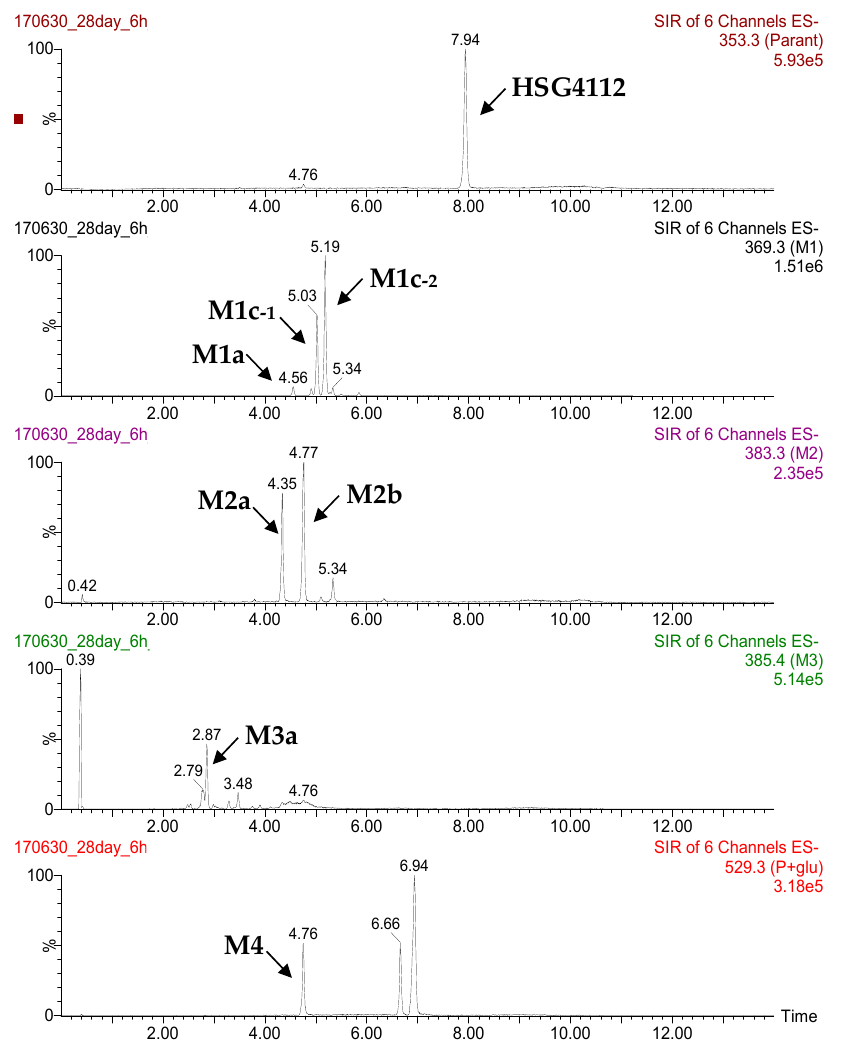
Figure 7. Representative extracted ion chromatograms of HSG4112 and its metabolites in rat plasma.